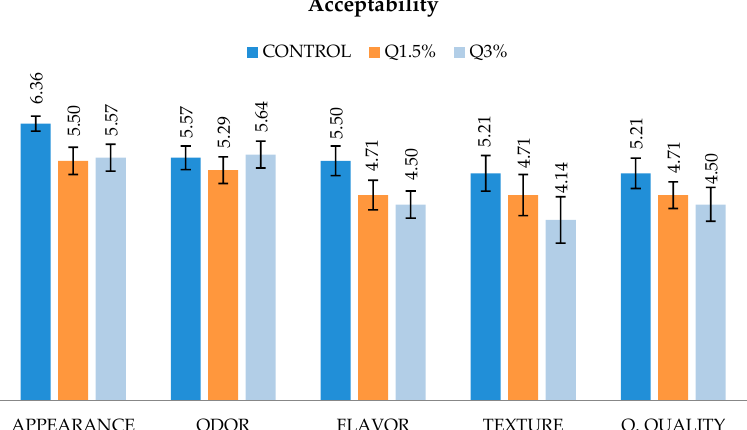
Figure 2. Sensory scores attributed on day 0 by the panel participants for appearance, odor, flavor, texture, and overall quality (O. quality) of low-fat cooked sausages made from turkey meat affected by white striping myopathy enriched with chitosan. Hedonic scale used: 1 = dislike very much; 2 = dislike moderately; 3 = dislike slightly; 4 = neither like nor dislike; 5 = like slightly; 6 = like moderately; 7 = like very much.